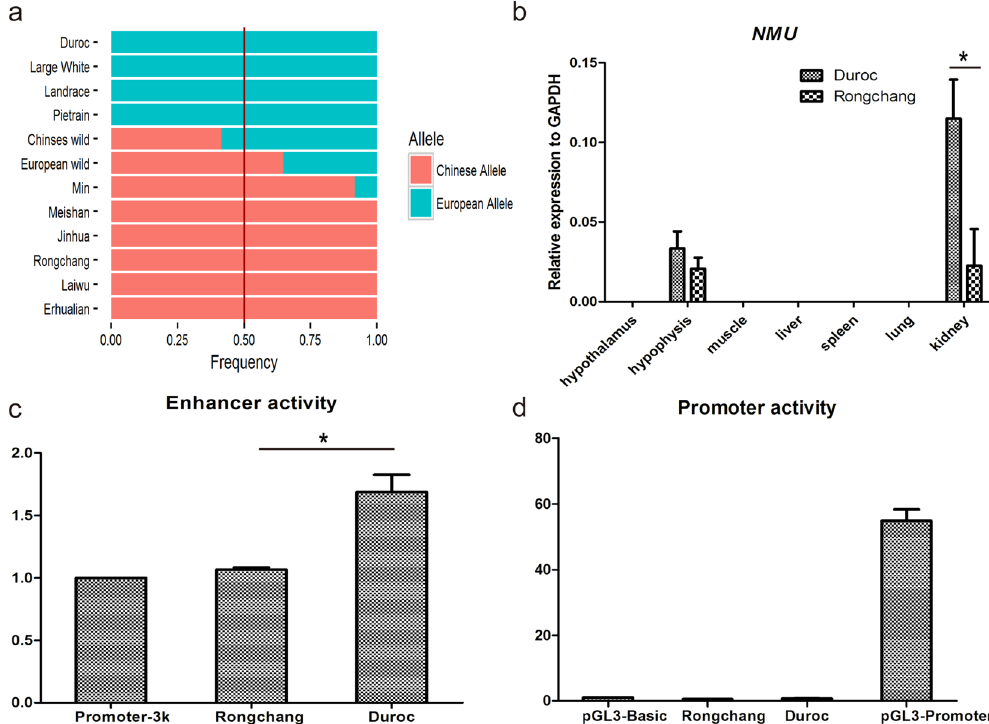
Figure 7. The variants in NMU and their effect. ( a ) The allele frequency of the NMU in each breed. ( b ) Quantitative RT-PCR Analysis of NMU between Rongchang and Duroc in different tissues. * P < 0.05 by Fisher’s exact test. ( c ) Luciferase assay testing the enhancer activity for different allele in the intron of the NMU in IBRS-2 cells. ( d ) Luciferase assay testing the promoter activity for different allele in the intron of the NMU in IBRS-2